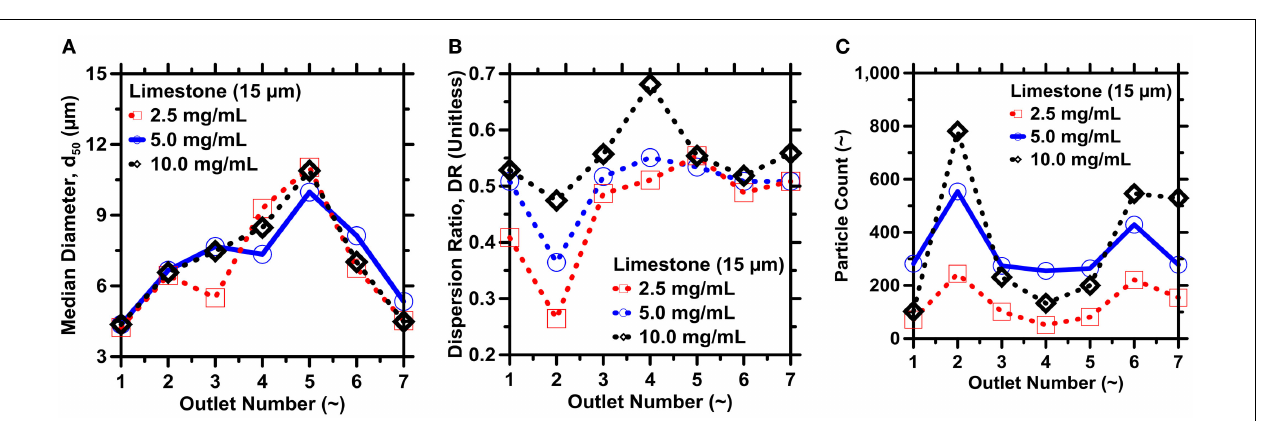
FIGURE 10 | (A) Median diameter ( d 50 ), (B) dispersion ratio, and (C) average particle yield for OPC particles retrieved from the different outlets. Excellent repeatability is observed across all three repetitions (runs). The highest